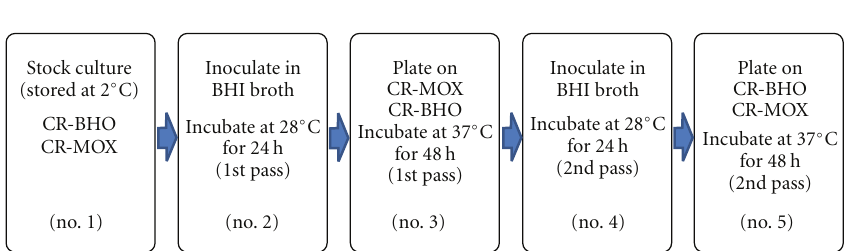
Figure 5: Confirmation of pYV in Y. pestis ,